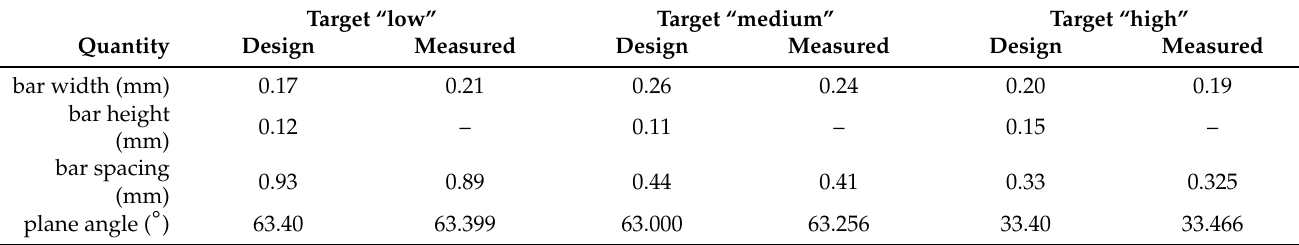
Table 7. Design parameters and measured values of the specimens designs using the KNN model. The printed specimens are measured using a 3D surface profilometer, quantities marked with a dash (’-’) could not be measured due to the measurement